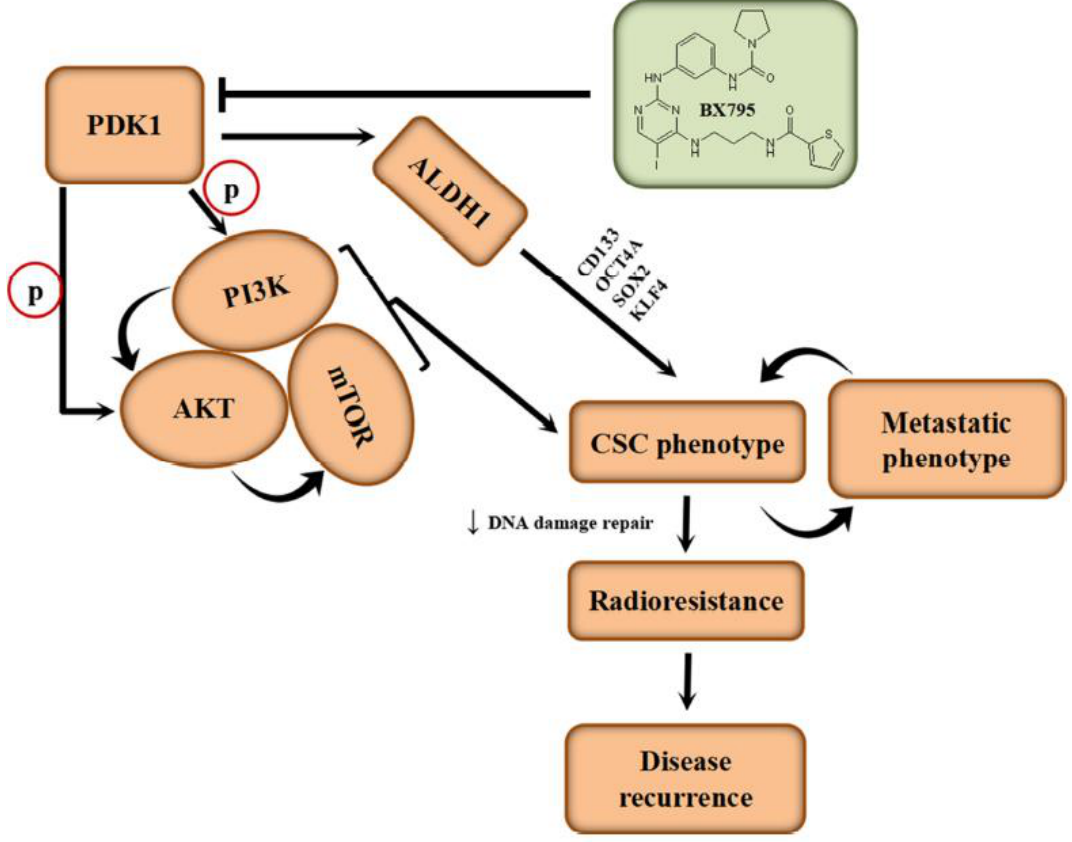
Figure 6. Schematic abstract of the aberrantly expressed PDK1 independently drives PI3K/AKT/mTOR oncogenic signaling in HCC. This present study demonstrated that aberrantly expressed PDK1 independently drives PI3K/AKT/mTOR oncogenic signaling, characterizes poorly differentiated cells, activates ALDH1 and is associated with the desensitization of aggressive hepatocellular carcinoma cells to radiotherapy. Supplementary Table S1. Antibody list. Supplementary Figure S1. PDK1 directly binds to and activates ALDH1. (A) ALDH1-PDK1 protein interaction matrix (upper panel) with local and global RMSD data indicated (lower panel). (B) ALDH1-PDK1 protein sequence alignment confirming complementarity. Supplementary Figure S2. PDK1 interacts with